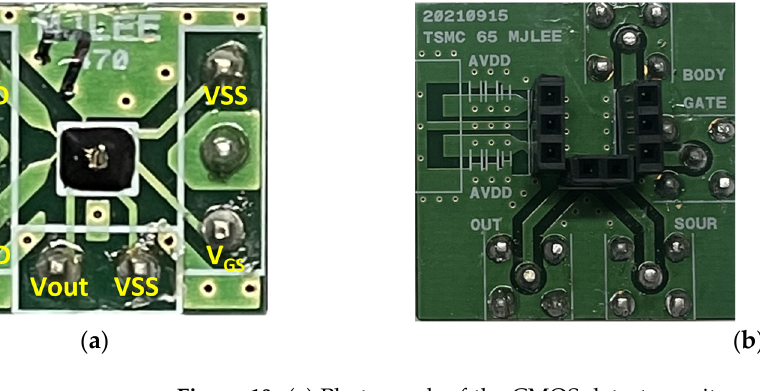
Figure 10. ( a ) Photograph of the CMOS detector unit module. ( b ) Adapter board to measure the voltage responsivity and noise-equivalent power of the unit module.